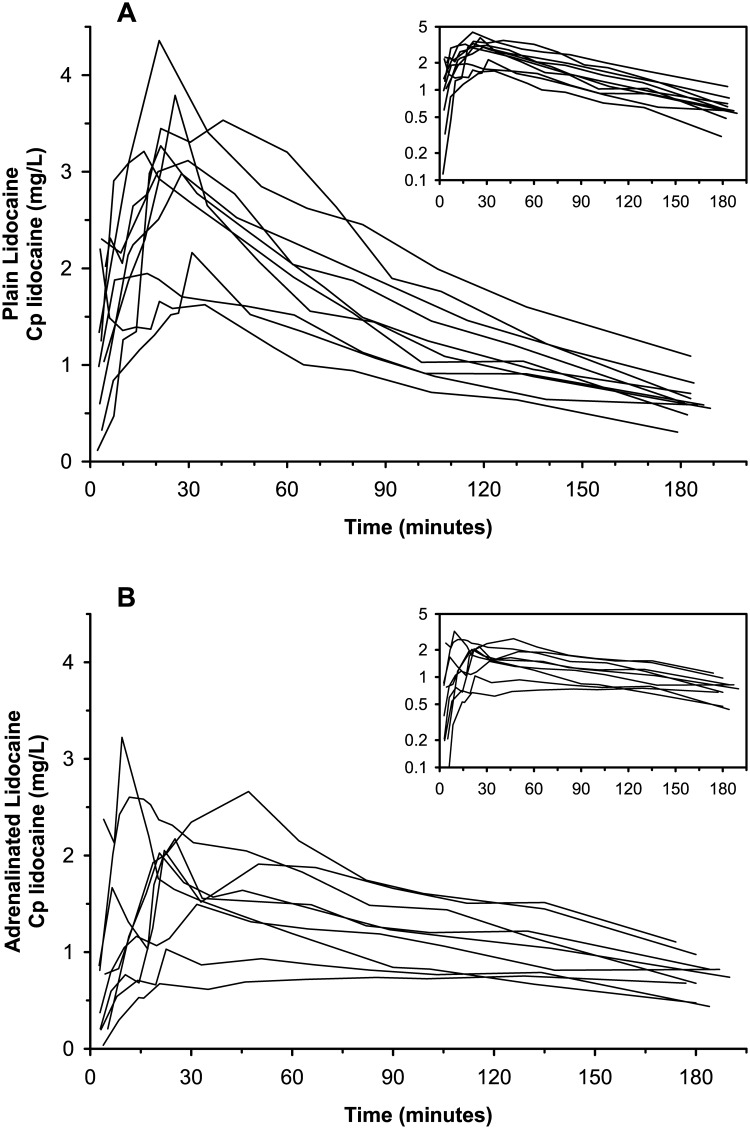
Individual time-courses of plasma lidocaine concentrations in dogs.(A) Paravertebral dosing of 6 mg/kg plain lidocaine formulation. (B) Paravertebral dosing of 6 mg/kg adrenalinated lidocaine formulation. The time-concentration data is delineated in linear coordinates (main graphs) and semilogarithmic coordinates (insert graphs).